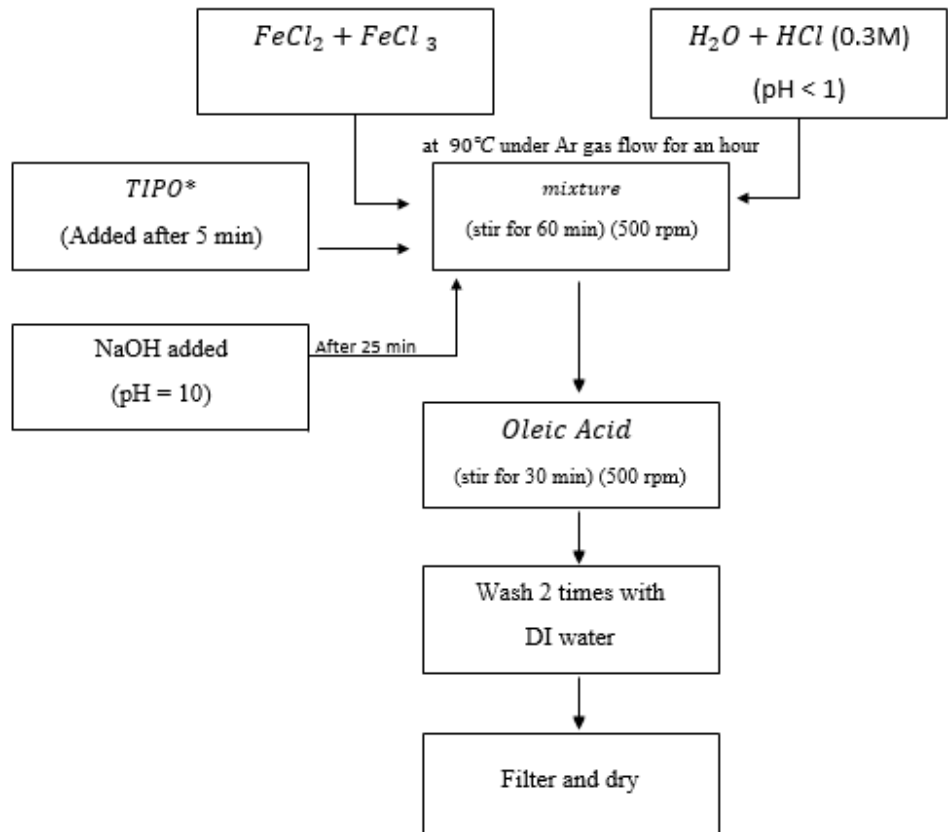
Figure 1. The schematic diagram of the synthesis procedure of pure and Ti-doped magnetite.